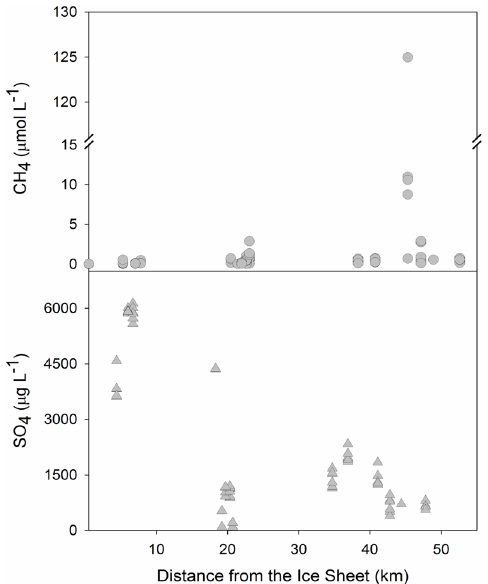
Fig 5. Patterns in lake-water methane and sulfate concentrations across the sampling region from the Greenland Ice Sheet outward in